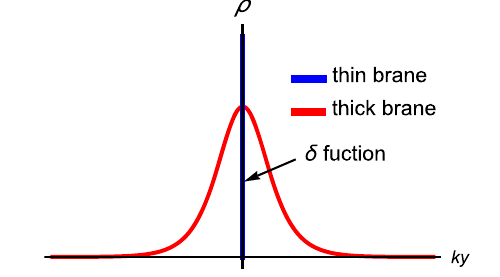
Fig. 1 The shapes of energy distributions of thin and thick